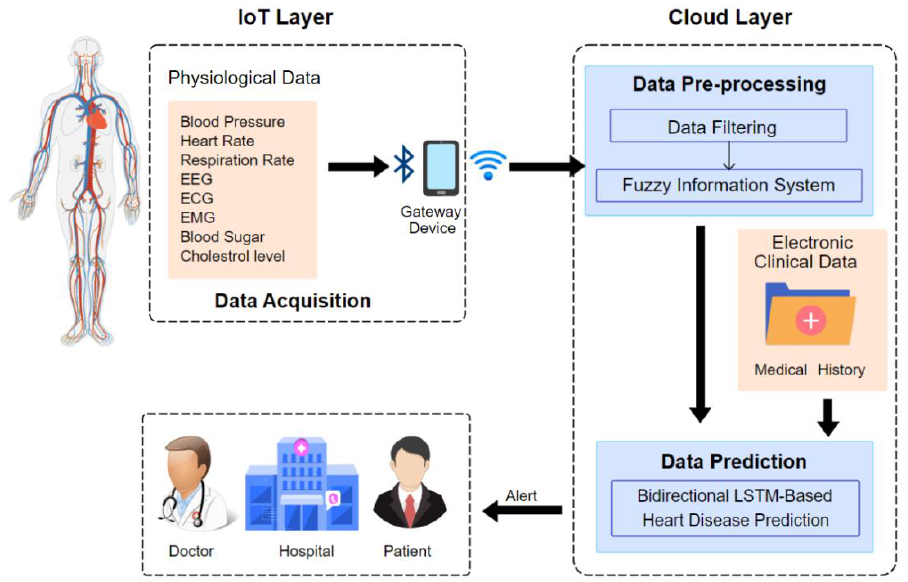
Figure 1. Heart disease risk prediction system—block diagram.